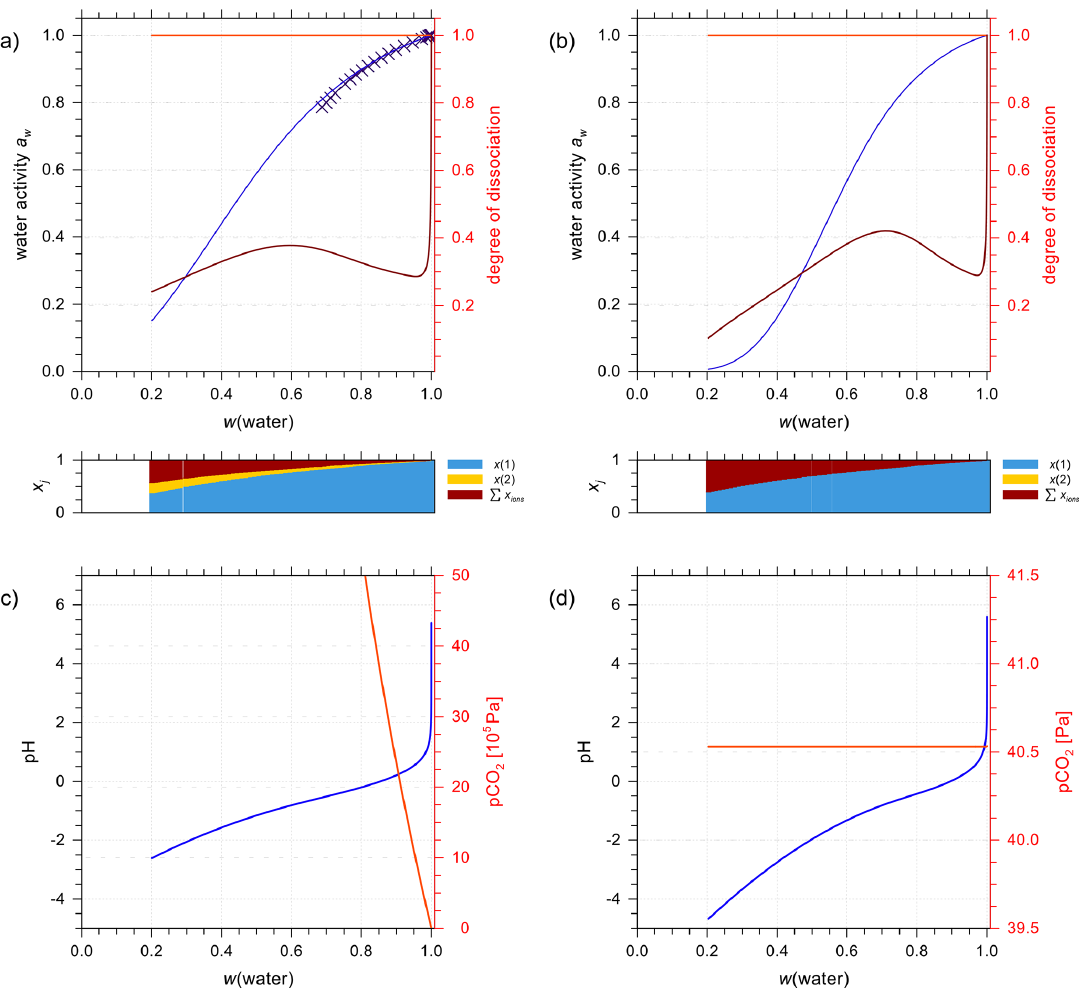
Figure 11. E-AIM (symbols) and AIOMFAC predictions (curves) of water activity for an aqueous solution containing H 2 CO 3 + H 2 SO 4 mixed 1 : 1 by moles at 298.15K (mixture species: water + CO 2(aq) + H + + HSO − (b) open system conditions. The AIOMFAC prediction of the degrees of dissociation are shown on the right y axis for HCO − curve) and HSO − (brown curve). (c,d) pH and partial pressure of CO 2(g) for (c) closed-system and (d) open-system scenarios (400ppm v 4 CO 2(g) ). Note the different axis